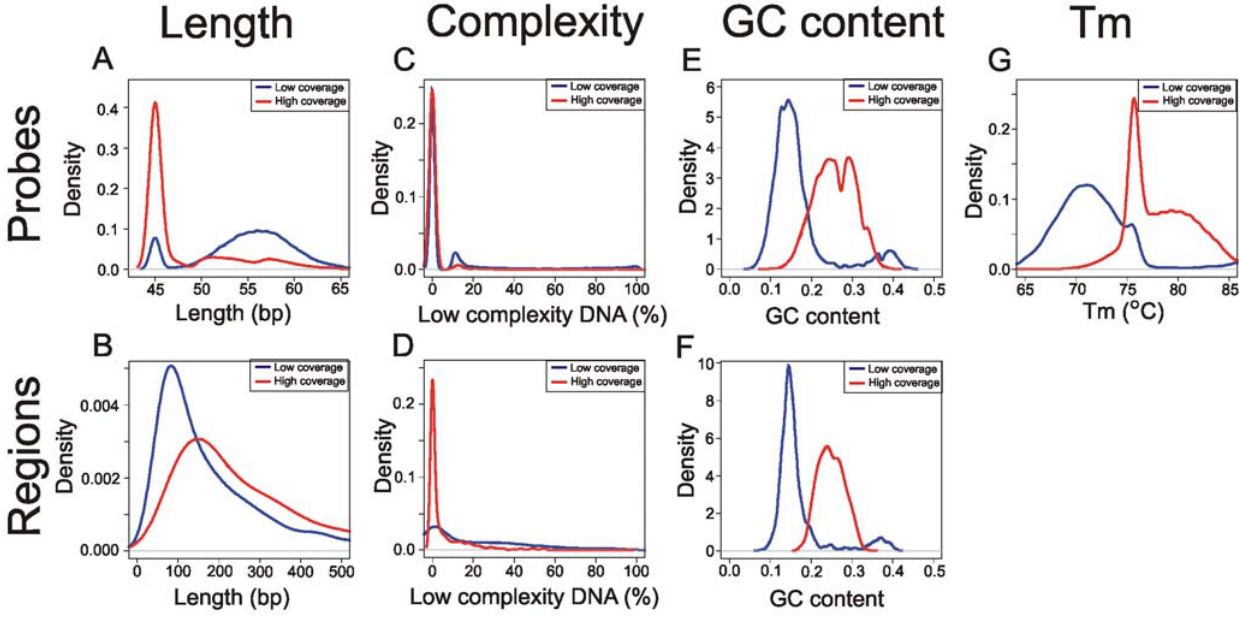
Figure 4. Distribution of sequence features of regions and corresponding probes with low ( , 3 fold) and normal (15-29 fold) sequence coverage. A,B) Length of the regions/probes. C,D) Percentage of low complexity DNA inside the regions/probes. E,F) GC content of regions/probes. G) Hybridization temperature of the probes.